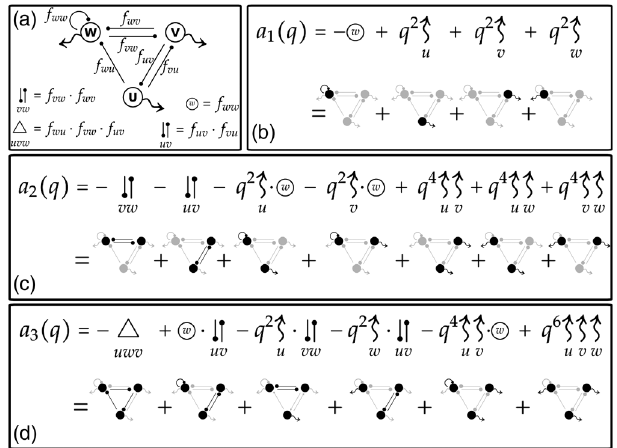
FIG. 2. (a) The reaction-diffusion graph of a three-species Turing system. Every edge is a nonzero entry of the reaction Jacobian, represented by f . Wriggled arrows denote that the ij species is diffusible. Symbolic notation for its four reaction cycles is shown below: a loop at w ; cycles of length 2 between u and v and between v and w ; and a cycle of length 3 between u , w , and v . ð q Þ for k ¼ 1 , 2, 3, given by the sum of (b) – (d) Calculation of a k all l -subgraphs of size 1,2,3, respectively. Every contribution is shown in the upper row using a symbolic graph notation, with the corresponding l -subgraph highlighted in black immediately